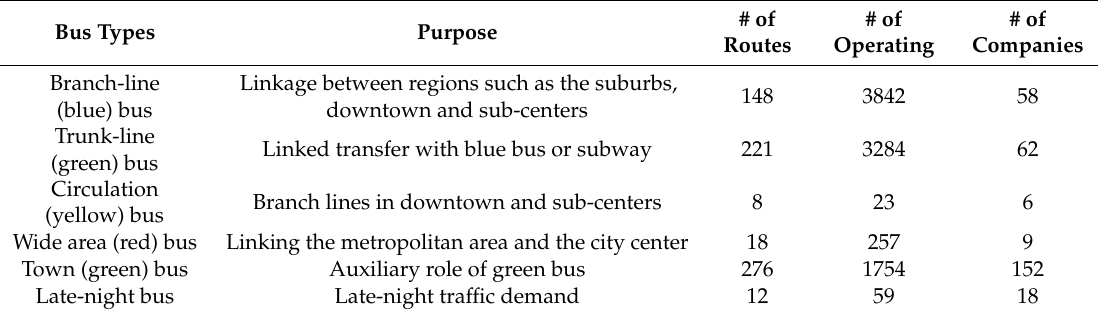
Table 1. Seoul Metropolitan City’s bus operation system (2019).